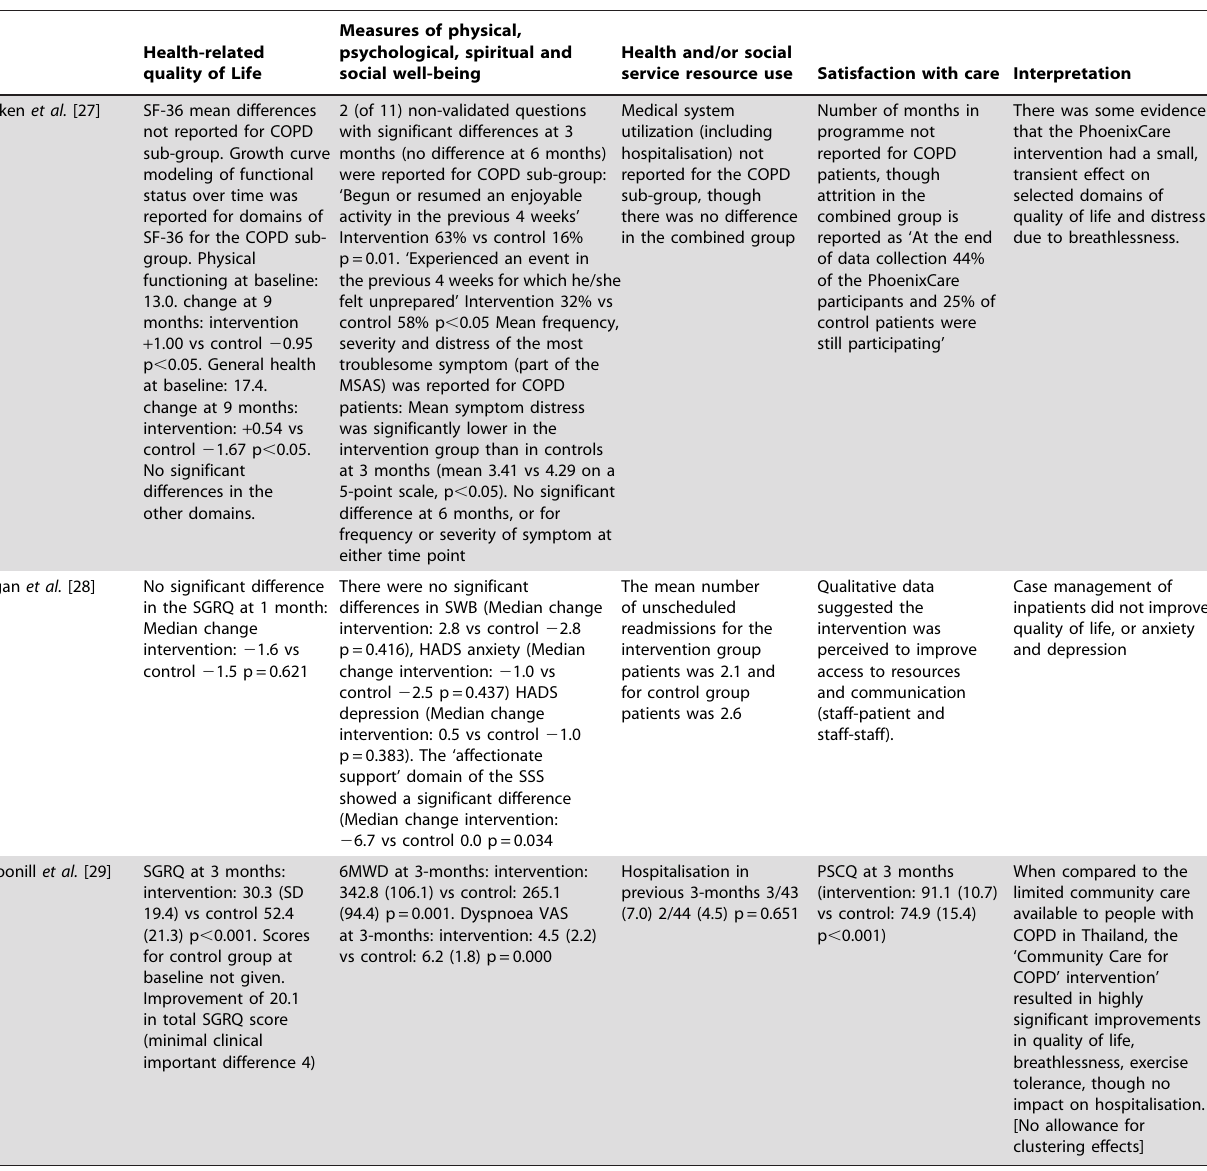
Table 3. Main findings and